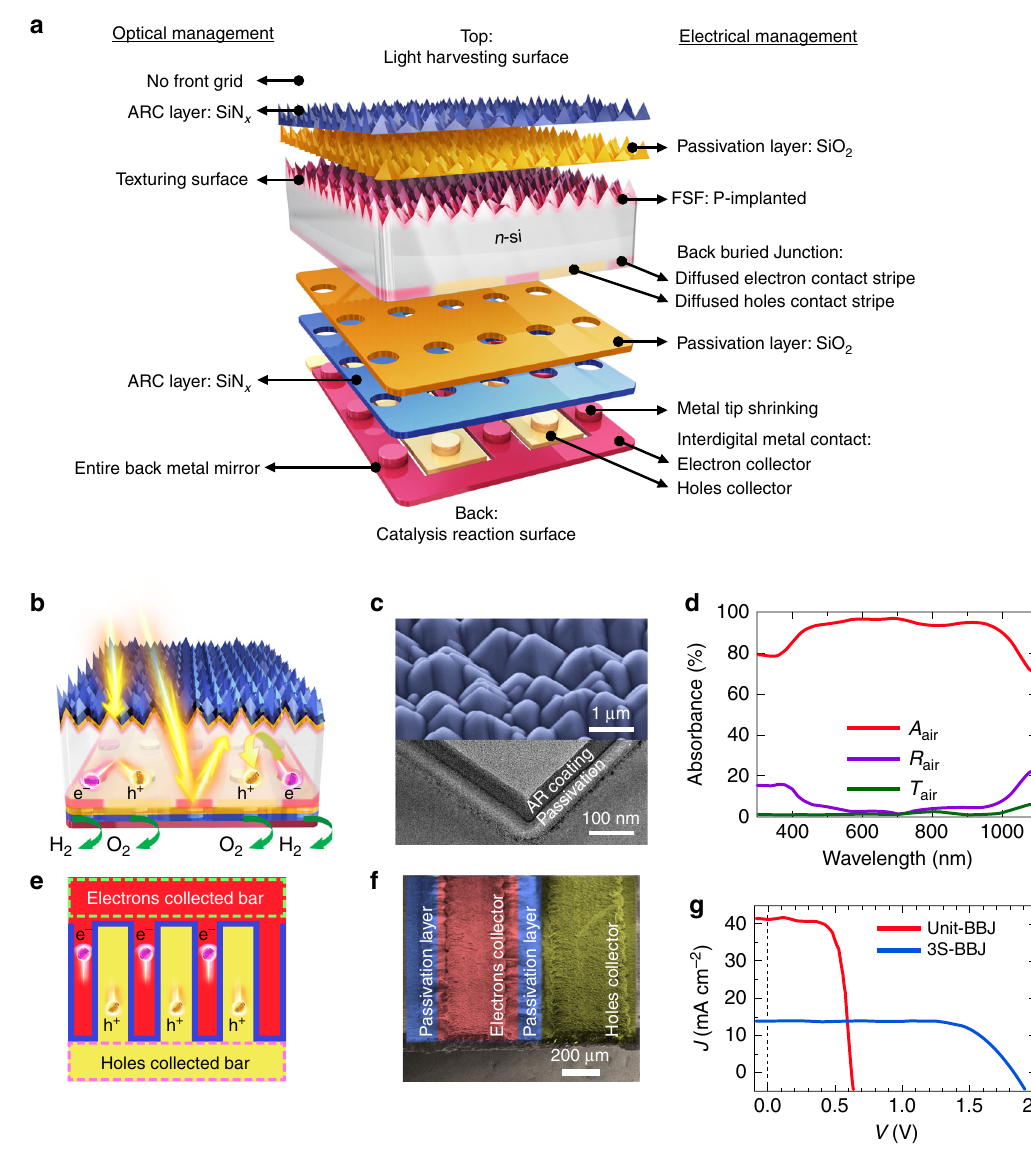
Fig. 1 The BBJ – PEC Cell. a Schematic of the components of the BBJ cell. b Cross-section and the optical trails of the BBJ cell. c The top panel displays an SEM image of the front surface of a BBJ cell textured with micropyramidal structures. The bottom panel shows a high-magni fi cation STEM image of the micro-pyramid surface, which features uniform passivation (SiO 2 ) and AR coating (SiN X ) layers. d The absorbance, re fl ectance, and transmittance spectra measured from the front pyramid surface. e The plane-view schematic of interdigitated dopant pattern of the BBJ cell. f A plane-view false color SEM image of the interdigitated metal grids on the back surface of the cell. g PV characteristics of a unit- and a 3S-BBJ